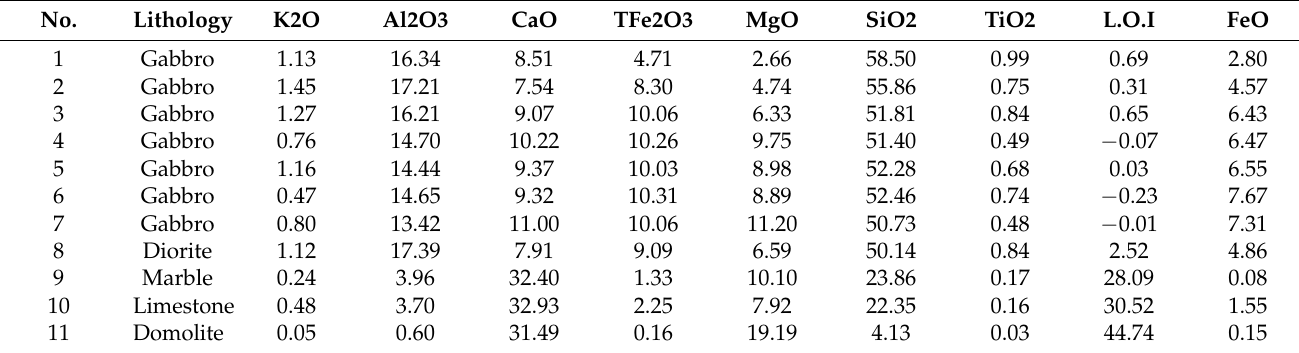
Table 2. Major elements of surrounding rocks.